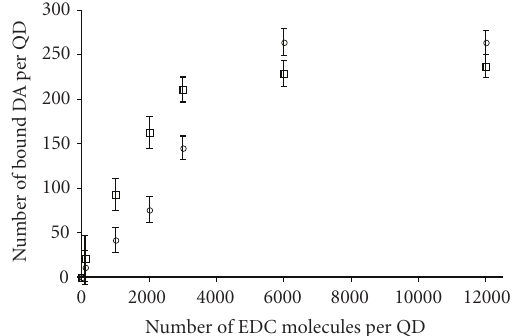
Figure 2: Number of bound dopamine molecules as a function of the number of EDC added to the coupling reaction for QD560 (squares) and QD605 (circles) as measured by OPA assay. Data are an average of three experiments with error bars indicating the stan- dard error of the